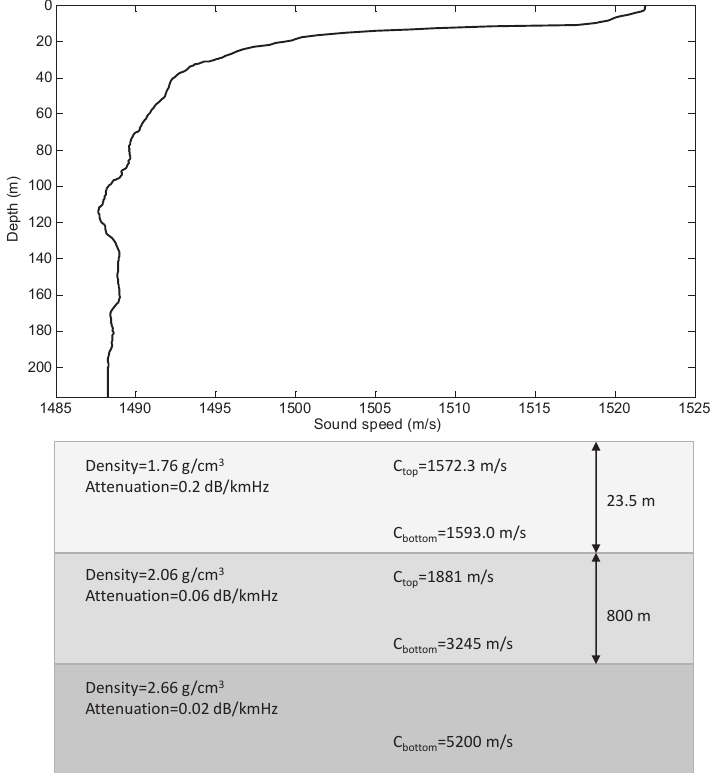
Figure 7. Waveguide with sound speed profile and geoacoustic parameters for range-independent SWellEx-96 Event S5.